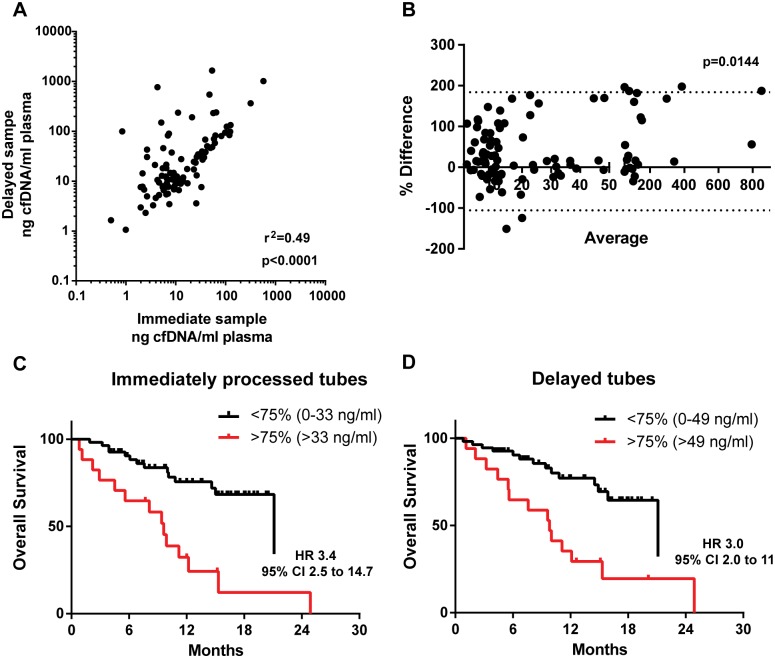
Comparison of total free plasma DNA levels between immediate processed EDTA samples and delayed processed Streck samples.A. Correlation plasma DNA levels of immediate processed EDTA samples and delayed processed Streck samples. Pearson correlation coefficient. B. Bland-Altman plot of data in part A with dashed lines representing 95% CI. C. Overall survival with plasma DNA quantified in immediate EDTA tubes divided on high plasma DNA levels above the upper quartile versus low plasma DNA below the upper quartile. Log rank test with hazard ratio (HR) and 95% confidence intervals (95% CI). D. Overall survival with plasma DNA quantified in delayed Streck tubes divided on high plasma DNA levels above the upper quartile versus low plasma DNA below the upper quartile. Log rank test with hazard ratio.